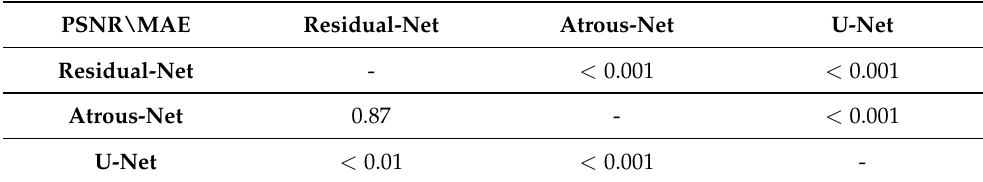
Table 14. MAE and PSNR p -values for 3D Head. p -values of paired Student’s t -test for MAE and PSNR results with 3D architectures with the head dataset.